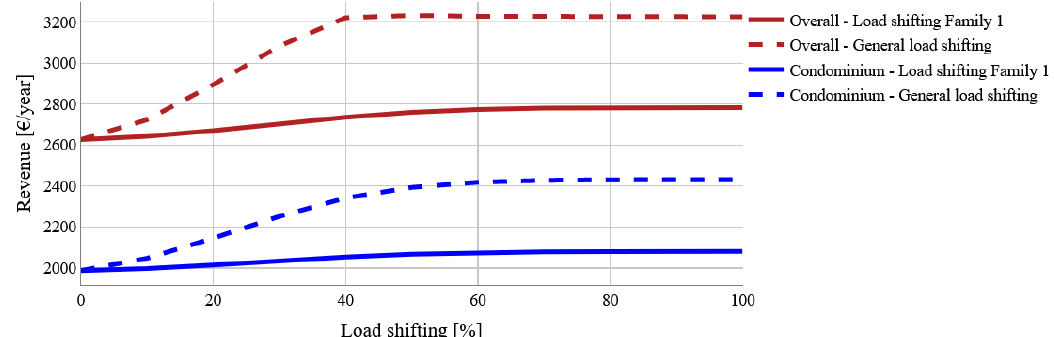
Figure 3. Impact of the load shifting on the overall yearly revenue and on the yearly revenue of the condominium (Scenario A-EC). Continuous lines represent the case of load shifting provided only by Family 1, dashed lines represent the case of load shifting provided by all the users.